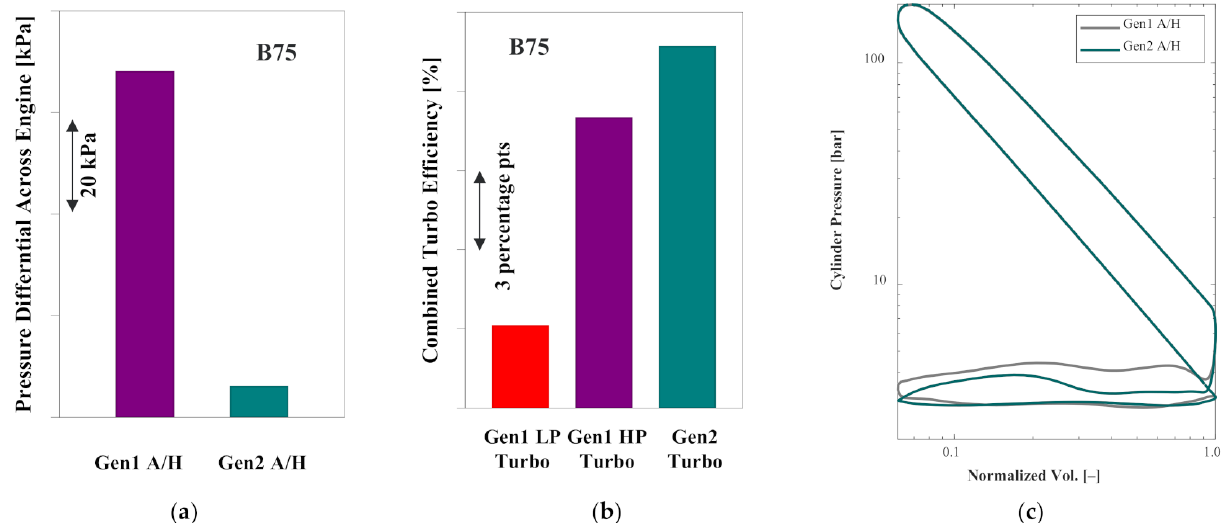
Figure 18. Comparison of gas exchange performance between Gen1 A/H and Gen2 A/H at B75: ( a ) pressure differential across engine; ( b ) combined turbocharger efficiency; ( c ) logP–logV.